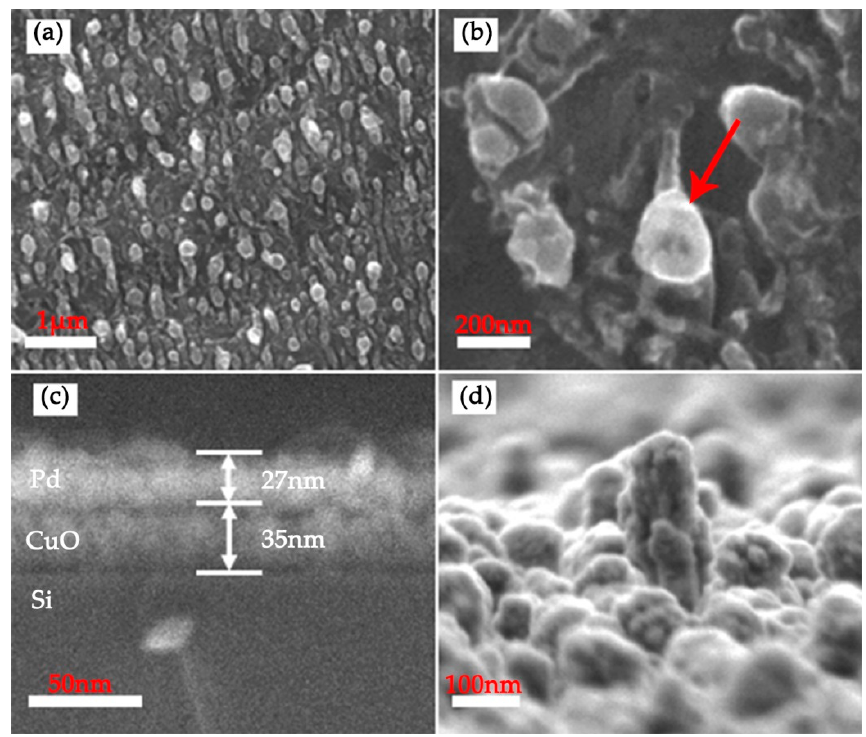
Figure 2. ( a , b ) SEM images (top view) of the Si nanospike before coating CuO and Pd heterostructured nanofilms; ( c , d ) SEM images (cross-sectional view) of the Si nanospike after coating CuO and Pd heterostructured nanofilms.